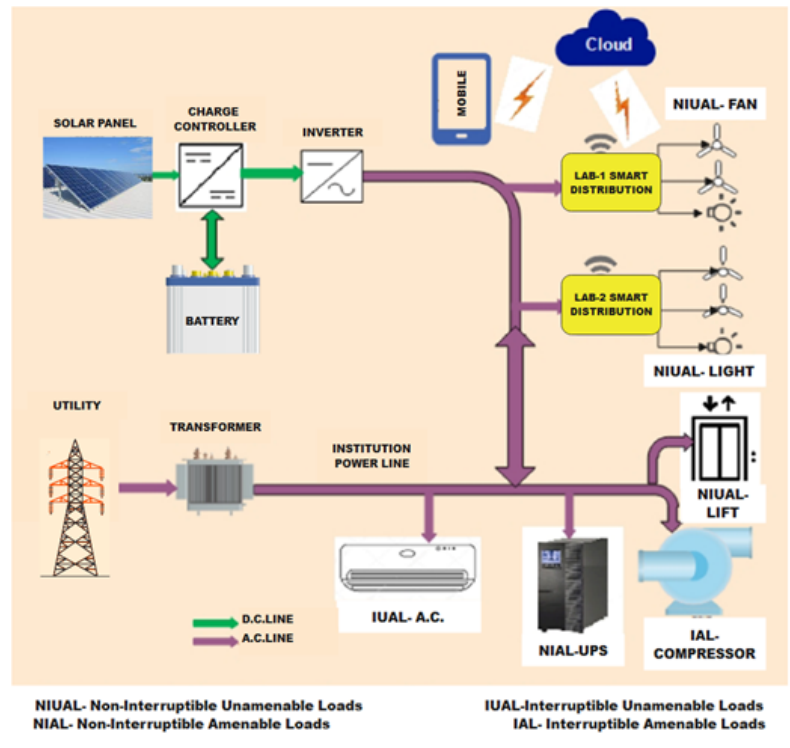
Figure 1. Overall implementation of various loads with